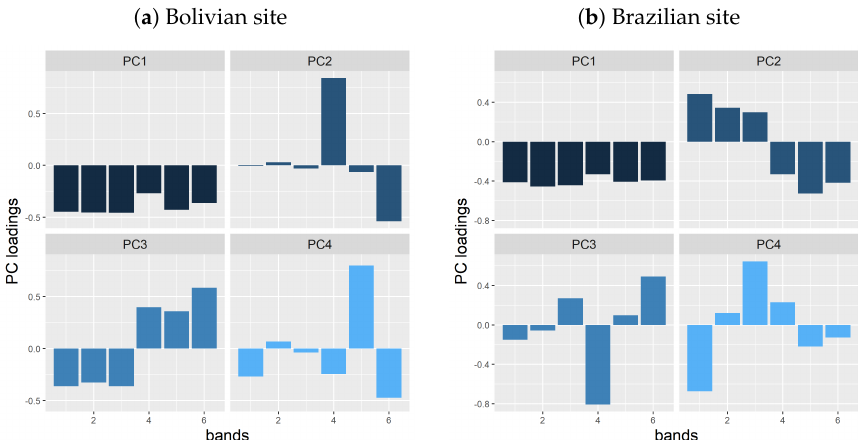
Figure 2. The PC loadings for all the testing time series containing no deforestation events at each site. The PC loadings with a band relationship that is indicated in PC3 of ( a ) and PC2 of ( b ) are selected based on (Equation